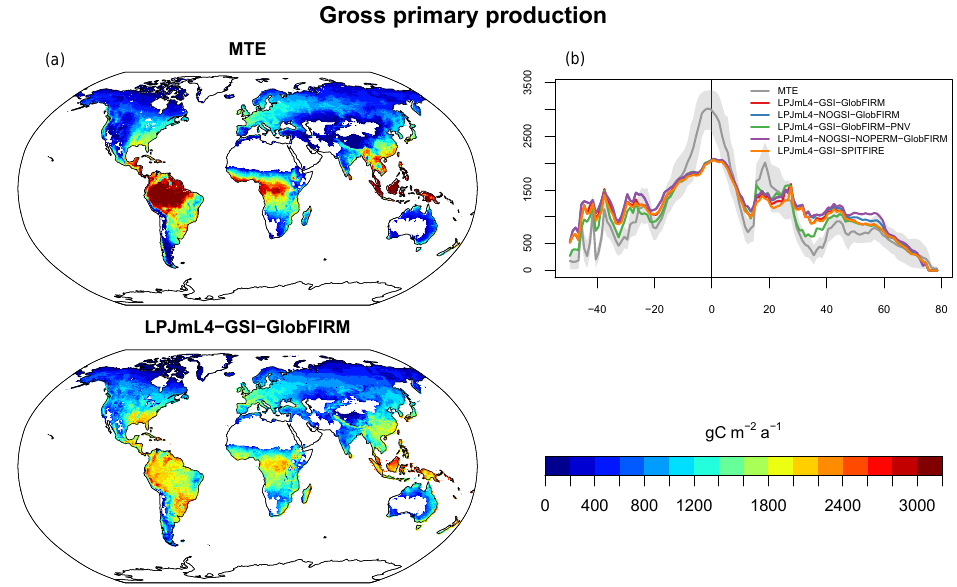
Figure 5. The maps (a) show the spatial pattern of gross primary production (GPP; gCm − 2 a − 1 ) distribution from the standard LPJmL4 simulation against the MTE data (Jung et al., 2011). The graph in (b) shows the latitudinal pattern of GPP distribution simulated by the different versions of LPJmL4 against data from Jung et al. (2011).